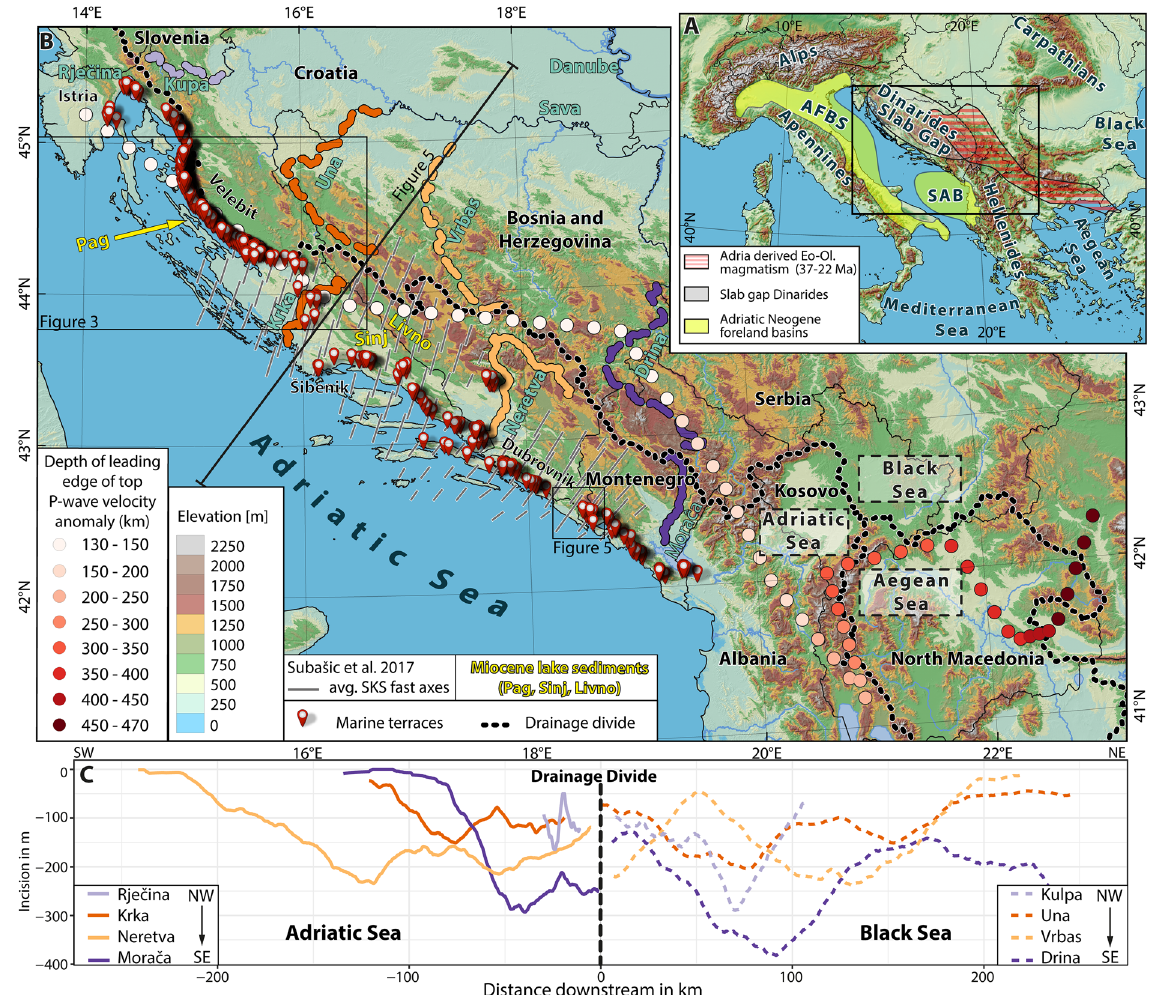
Figure 1. (a) DEM 34 of Circum-Adriatic orogens, location of the Eo-Oligocene magmatic domain 20 and locations of Neogene foreland basins (AFBS: Apennine Foreland Basin System) 68 ; SAB: South Adriatic Basin 54 . (b) DEM 34 with the position of all mapped marine terraces located within the Dinaric slab gap. Spaced dots show the leading edge of the slab top extracted from the mapped positive velocity anomalies of tomography model UU-P07 24,25 . Shear wave splitting axes indicate the direction of orogen-perpendicular mantle flow 26 . Black dotted line shows drainage divide separating the Adriatic, Black and Aegean Sea catchments. Yellow labels point to locations of coastal-near Miocene freshwater sediments. (c) Swath profiles along the Dinaric rivers show a symmetric incision across the drainage